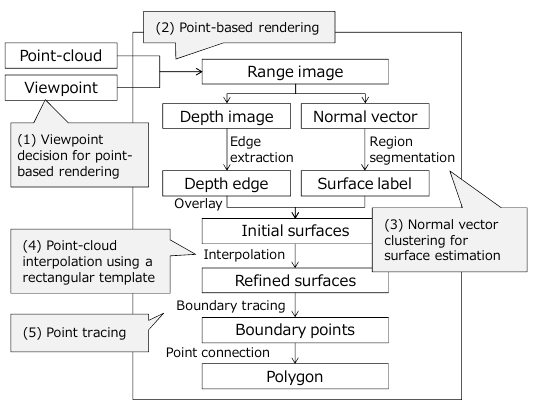
Figure 1. The five components of processing